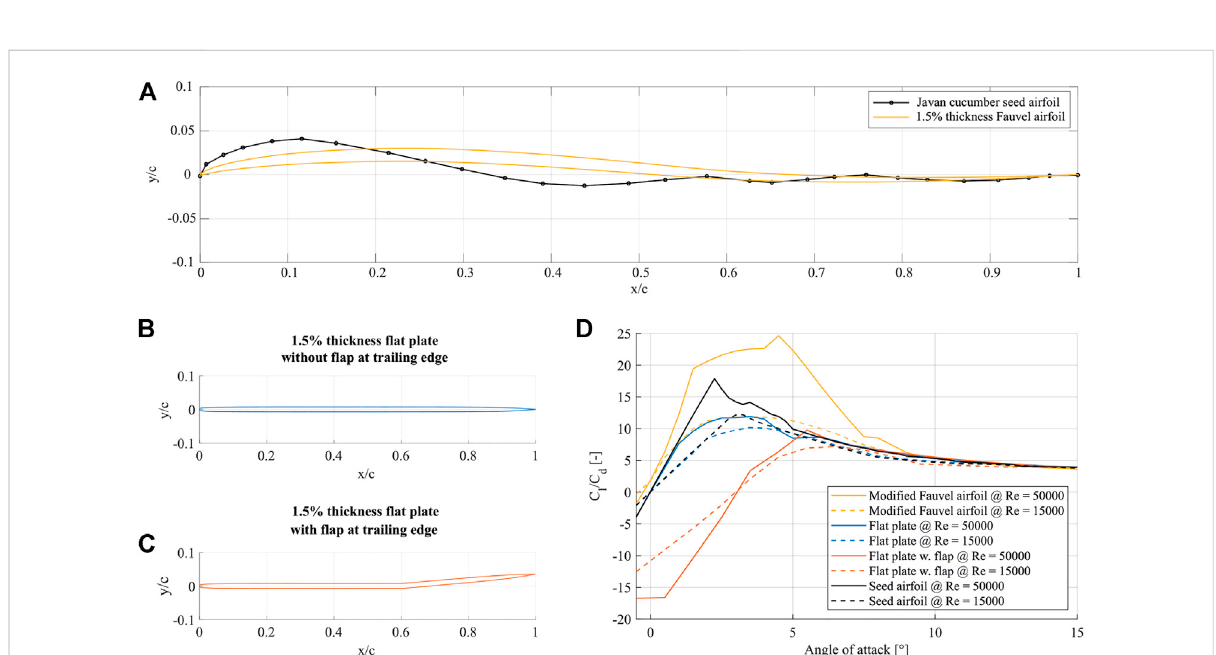
FIGURE 3 Side-view of the selected airfoils for the bio-inspired glider. (A) gives the airfoil height normalized by the chord-length versus the chord normalized by the chord-length of the modi fi ed Fauvel airfoil compared to the Javan cucumber airfoil according to Azuma and Okuno (1987), (B) gives the side-view geometry (normalized height versus normalized chord) of the investigated fl at plate at 1.5% thickness, (C) gives the side-view geometry (normalizedheight versus normalized chord) of the investigated fl at plate airfoil with a fl ap in the trailing edge and 1.5% thickness,